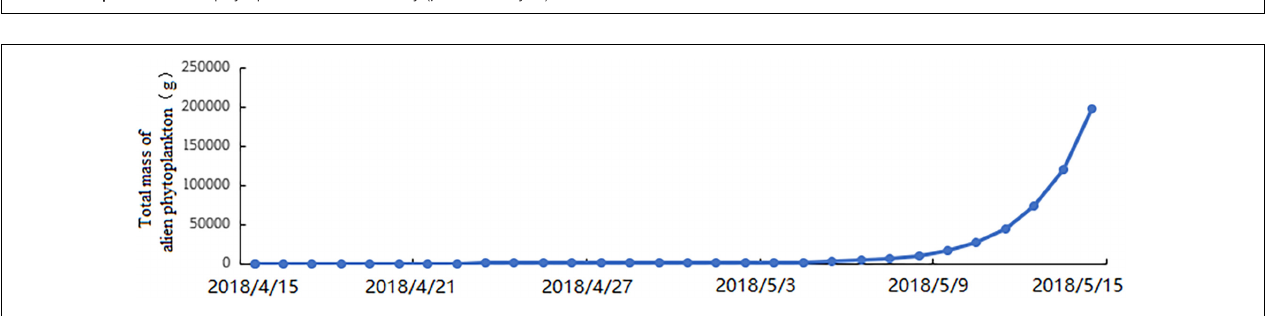
FIGURE 9 | Mass of alien phytoplankton in Bohai Bay ( µ (cid:48) = 0 . 1 day − 1 ).